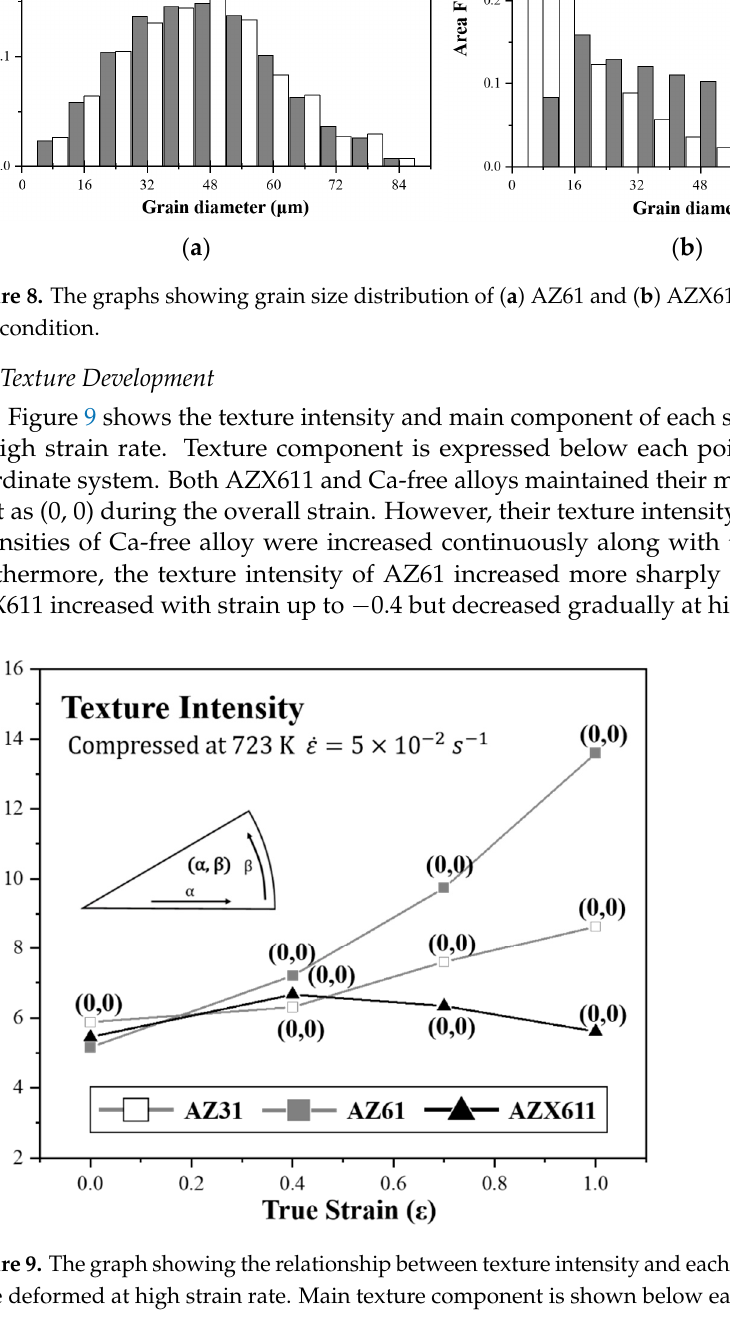
( b ) Figure 7. The ( a ) band contrast image and ( b ) KAM map of AZX611 specimen shown in Figure 5c.